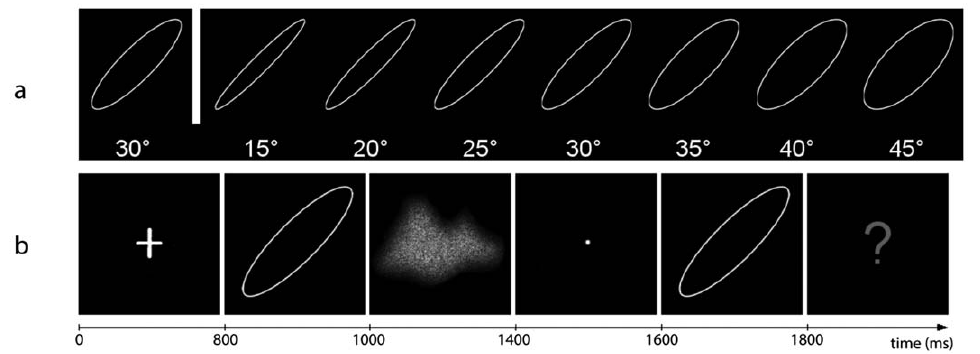
Figure 4. Organization of the Visual discrimination task. (a) Example of the relationship between one Standard Ellipse (here 30 u , left side of the figure) and its corresponding 7 Test Ellipses. (b) Time sequence of one experimental